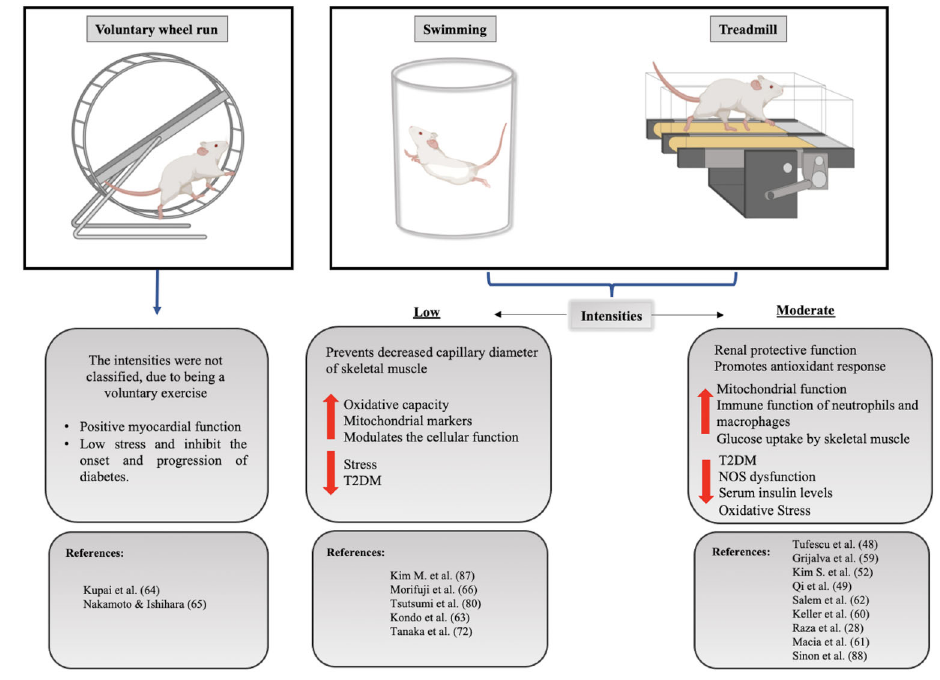
Figure 3. Main fi ndings reported in the reviewed articles on physical exercise in Goto-Kakizaki (GK) rats.